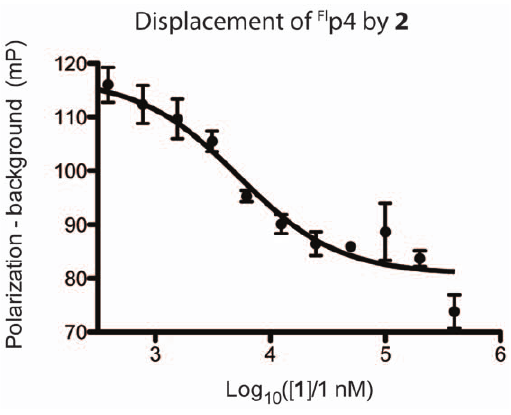
Figure 5. Fluorescence polarization measurement of Fl p4 peptide (K d of 0.16 m M with HDM2) being displaced by spiroligomer 2. The fit curve is consistent with a K i value of 5 m M.